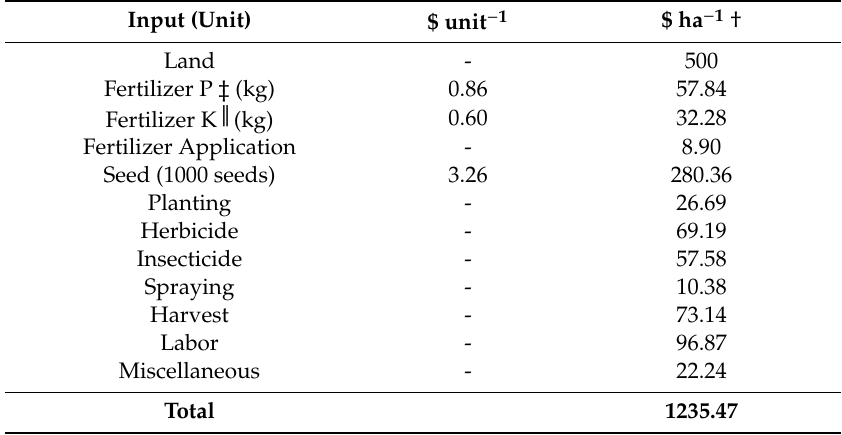
Table A1. Fixed costs associated with grain production in conventional and KCLM systems.